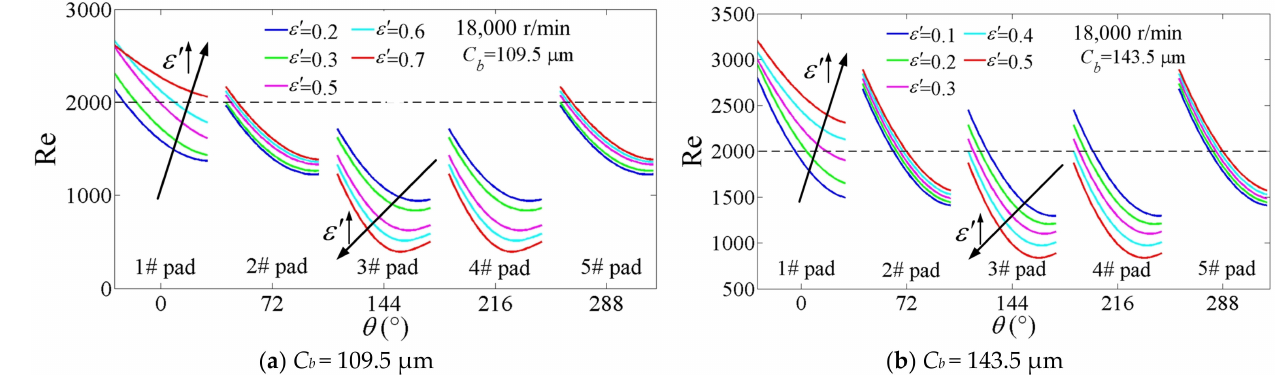
Figure 3. Distributions of the local Reynolds number of each pad of tilting pad bearing at different assembled eccentricity ratios and assembled